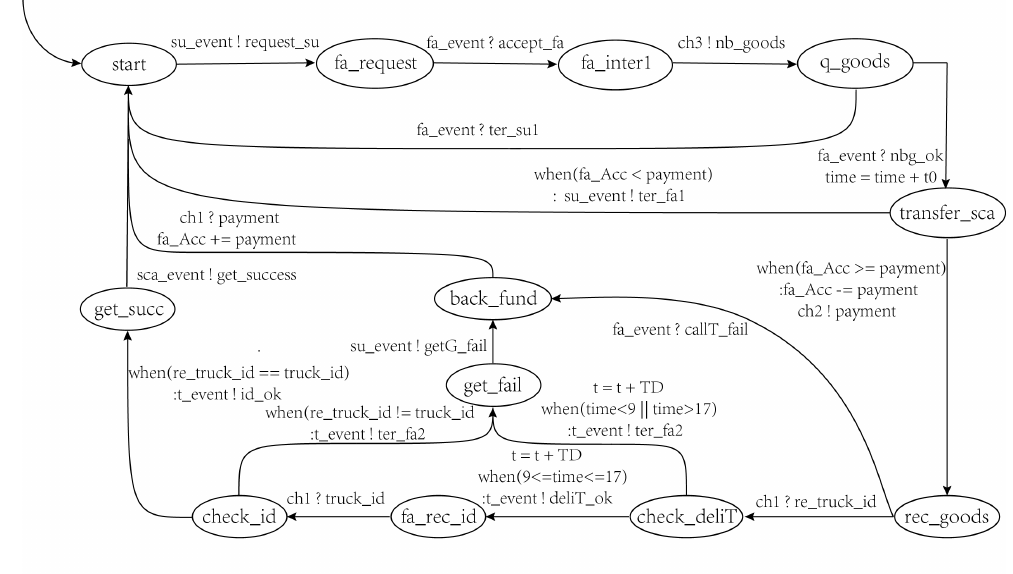
Figure 7. The factory